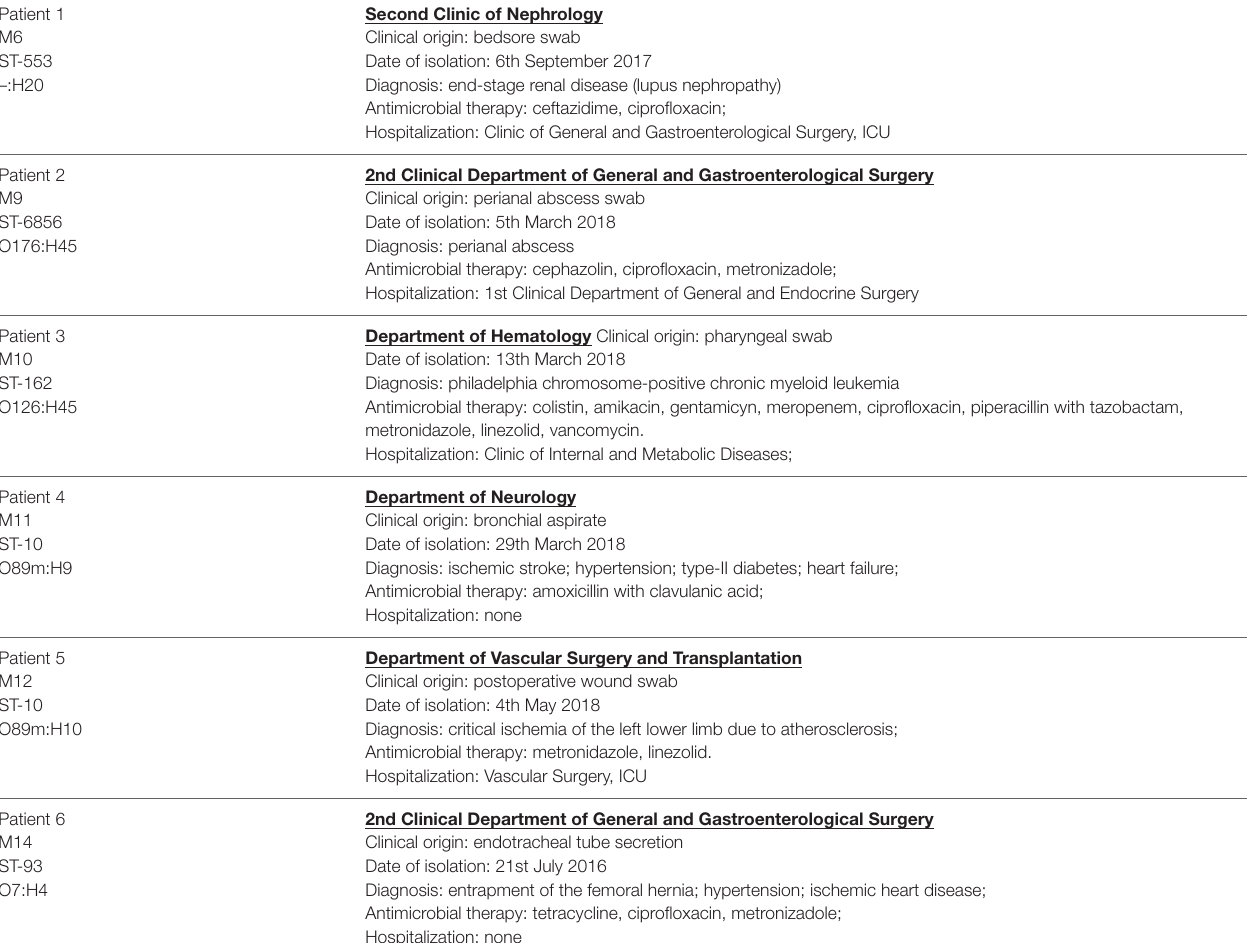
TABLE 1 | Clinical characteristics of the patients colonized by extraintestinal mcr- 1.1-producing E. coli